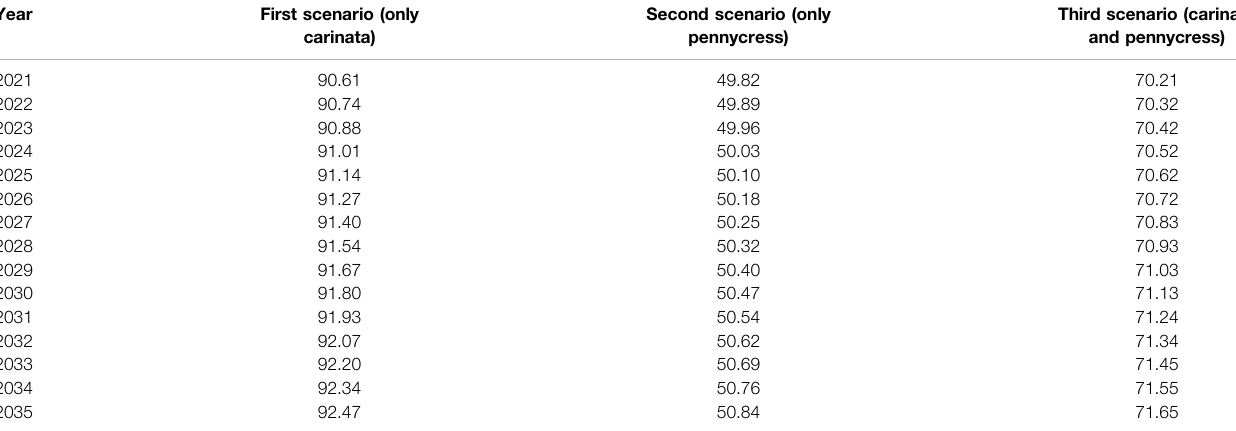
TABLE 2 | Emission savings for carinata and pennycress from 2021 to 2035. Year